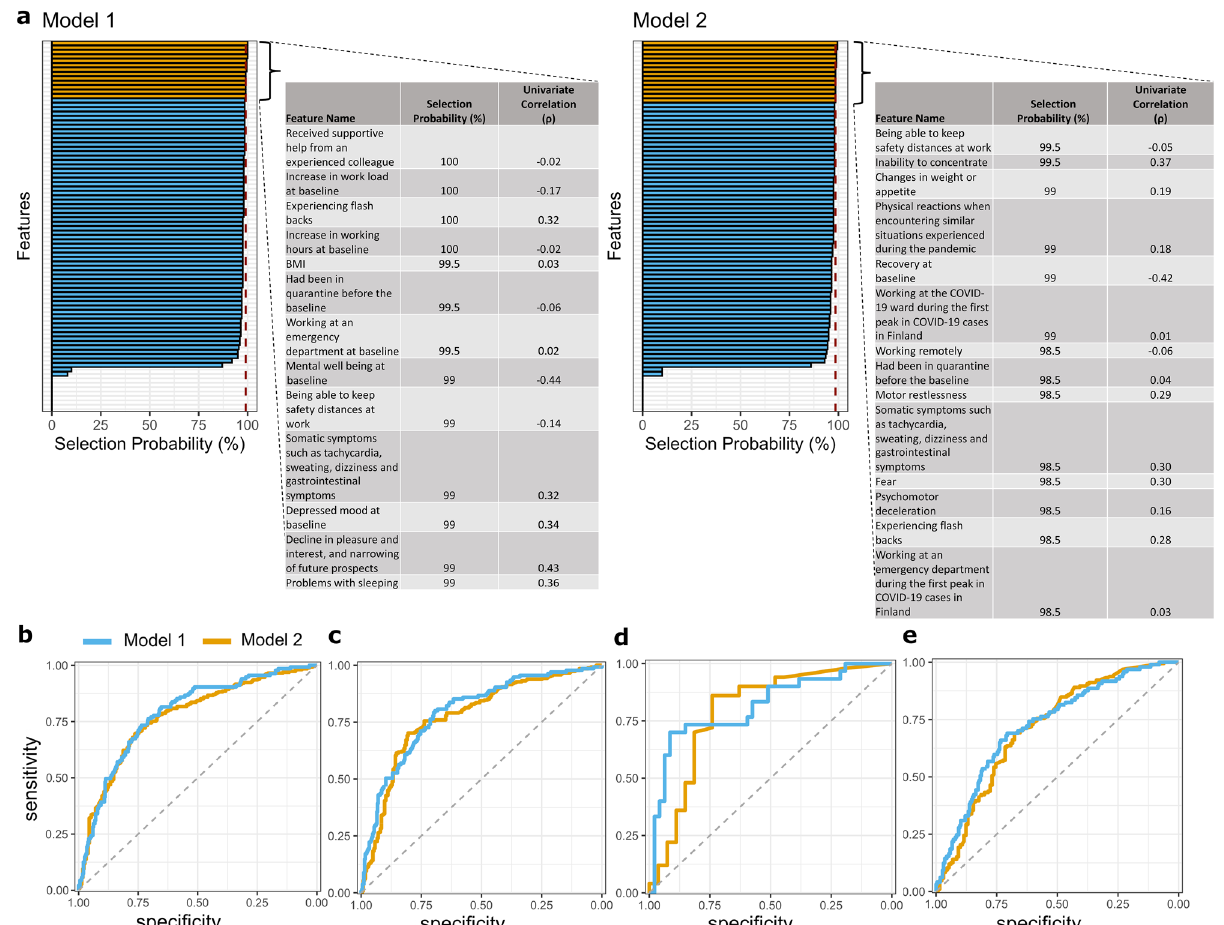
Figure 2. ( a ) Composition of predictive variable sets selected by Model 1 ("immunity") and Model 2 ("bouncing back"). The most predictive features are in yellow. ( b ) The performance of the full models in the HUS. The performance of the condensed models in ( c ) HUS, ( d ) Kymsote, and ( e ) The City of Helsinki